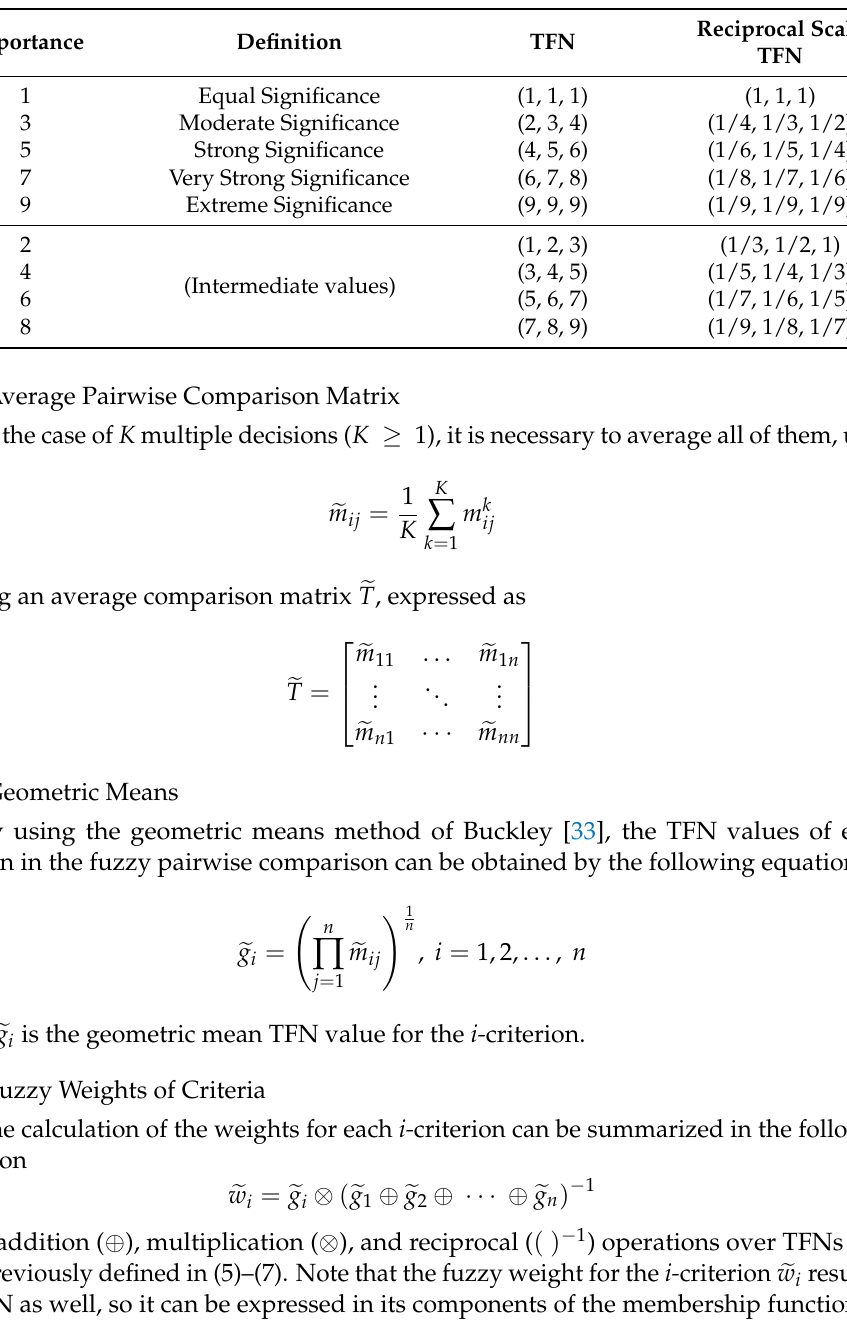
Table 1. Saaty scale of